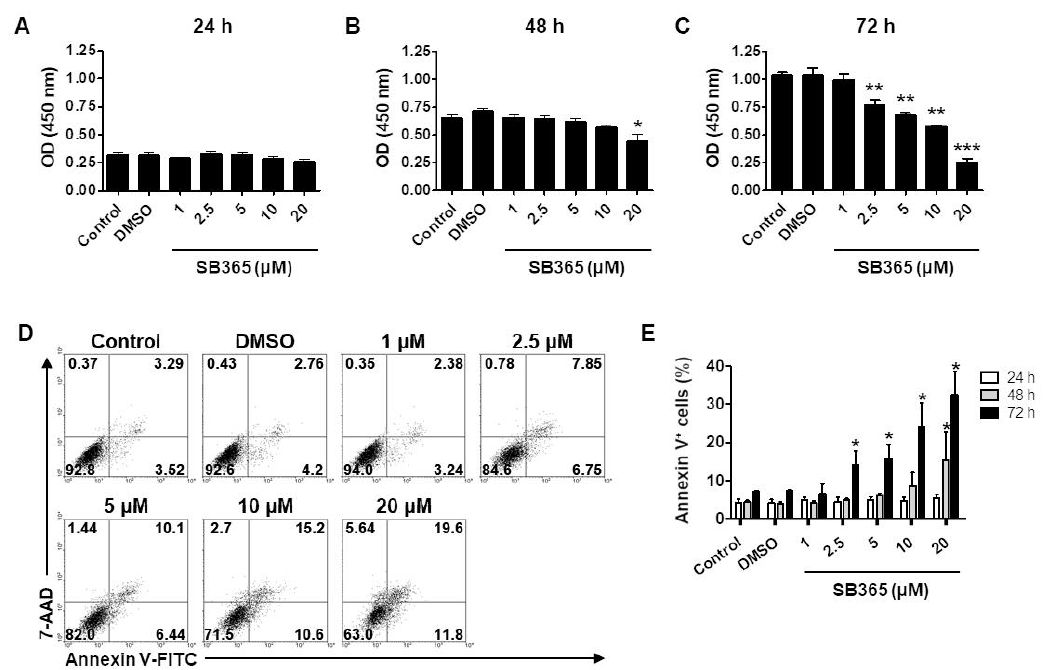
Figure 1. SB365 exerted a cytotoxic effect on U87-MG cells. ( A – C ) SB365 inhibited the proliferation of U87-MG cells. The cells in 96-well plates were treated with SB365 at the indicated concentrations for ( A ) 24, ( B ) 48, or ( C ) 72 h in quadruplicate, and subjected to CCK-8 assay. ( D , E ) SB365 increased the frequency of the annexin V-positive cells. U87-MG cells in six-well plates were treated as above, stained with annexin V and 7-AAD, and subjected to FACS analysis. ( D ) A representative FACS profile after 72 h and ( E ) the frequency of annexin V-positive cells. Experiments were performed independently in triplicate. * p < 0.05, ** p < 0.01, and *** p < 0.001 vs the control.